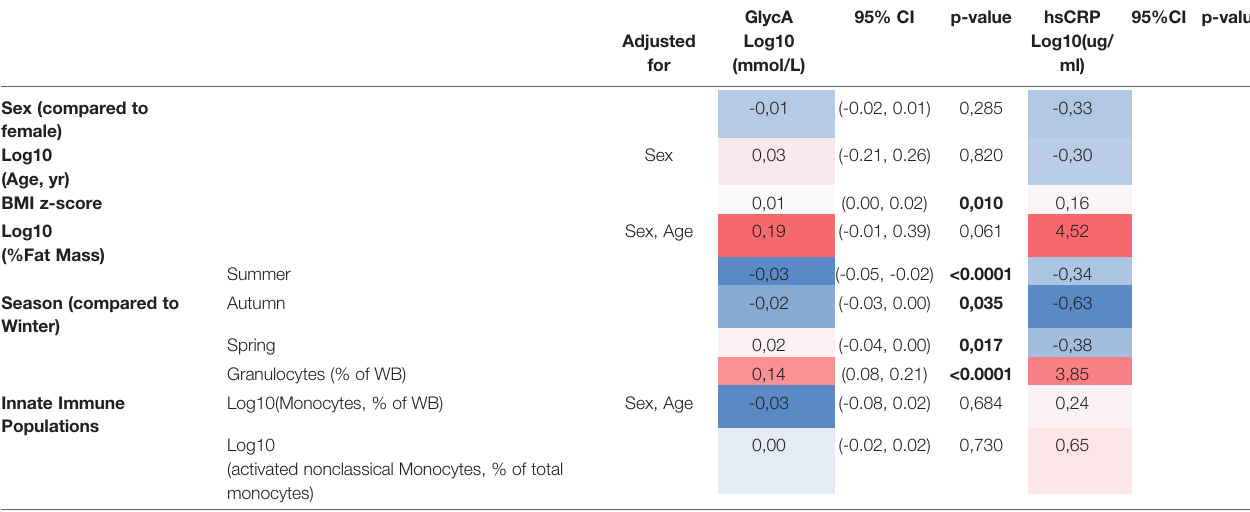
TABLE 1 | Associations between in fl ammatory factors and sex, child age, adiposity (BMI and %fat mass), seasons and innate immune cell proportions.